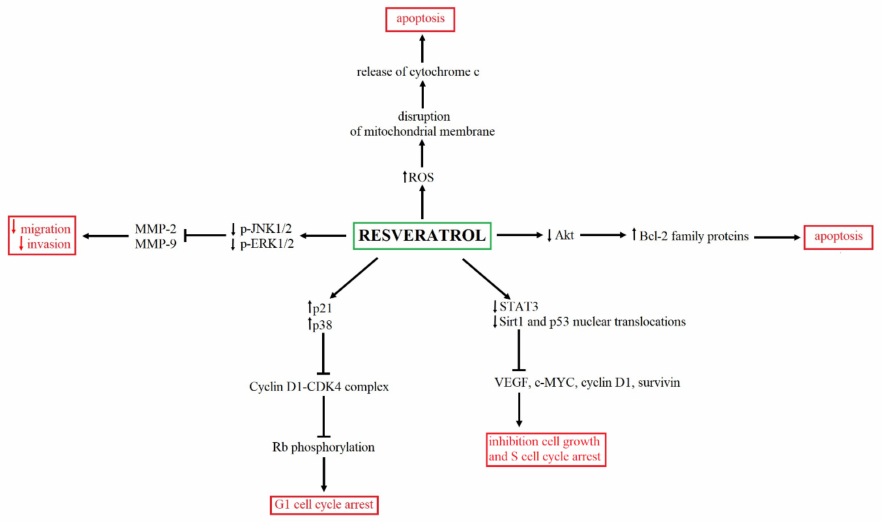
Figure 3. The summary of anticancer effects and mechanism of RSV action. RSV may modulate numerous signaling pathways, including cell cycle [73–76,80–82], metastasis [83], as well as apopto- sis